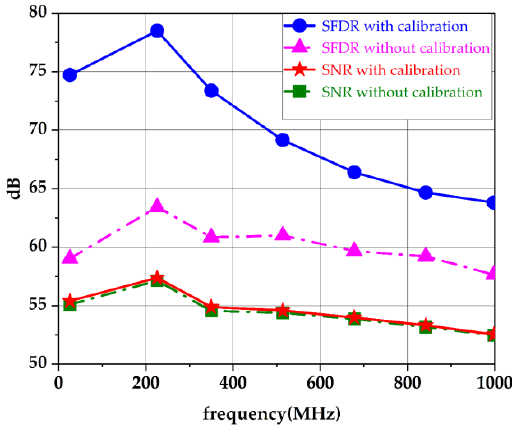
Figure 18. the ADC performance before and after calibration versus the input frequency . ( a ) Figure 18. The ADC performance before and after calibration versus the input frequency. SNR/SFDR of this ADC versus frequency of the input signal with and without calibration at 1 G Table 2. Performance comparison of measured ADCs.